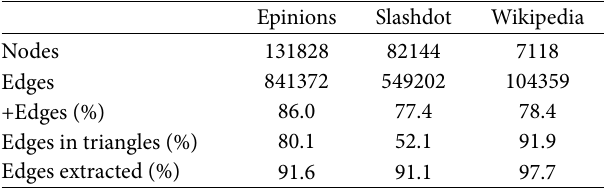
Table 1: Algorithm of pseudo-code of 𝑆𝑃𝑅 -model. Table 2: Three real social signed networks.